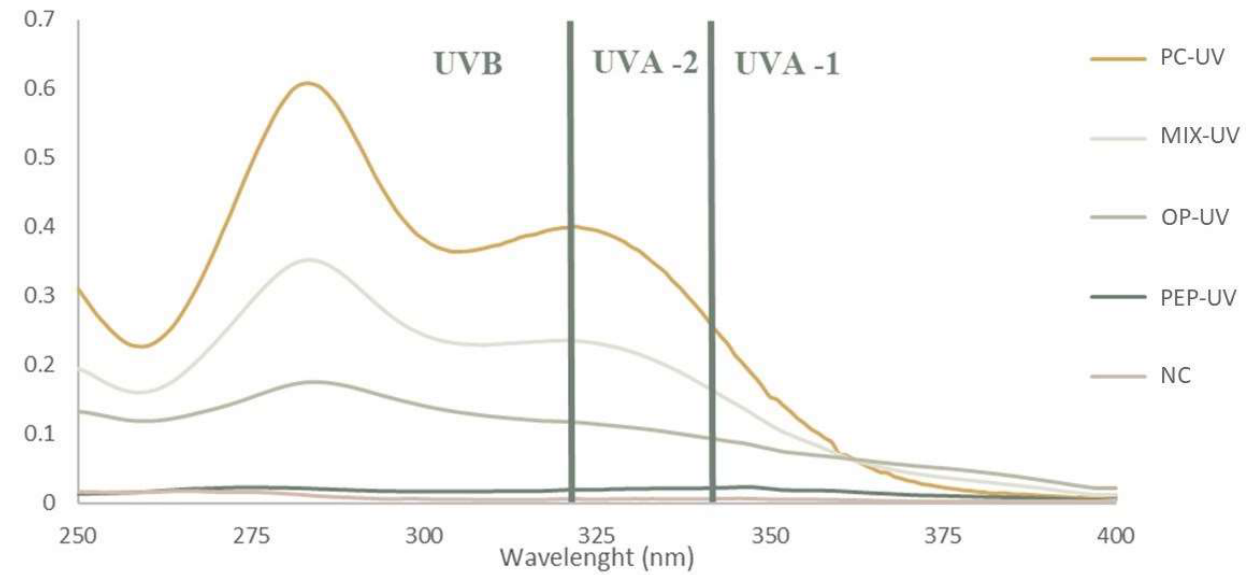
Figure 9. Absorption spectra used to determine the sun protective factor (SPF) of formulations. NC: negative control; PC-UV: positive UV filter control; OP-UV: onion peel extract UV filter sample; PFP-UV: passion fruit peel extract UV filter sample; Mix-UV: mixture of UV filter control and OP and PFP extract.